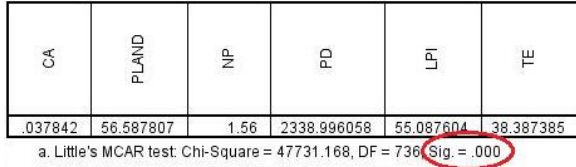
Figure 5. Result of Little‟s MCAR test. Circled in red shows the significance to be .000 which shows the data to be MNAR.